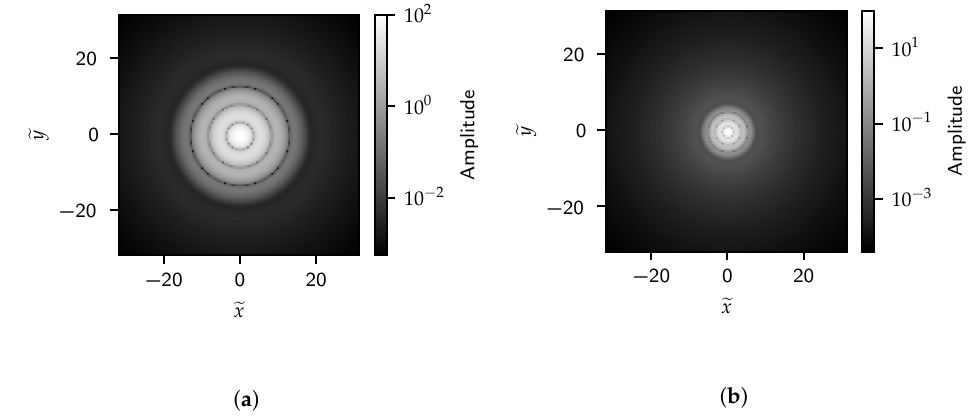
Figure 6. A 2D FFT of the single circle image with ( a ) r 0 = 0.1 and ( b ) r 0 = 0.25. Figure 7 shows the 1D projection of the FFT results onto the effective frequency space. The blue dashed line in Figure 7 indicates the effective frequency corresponding to r 0